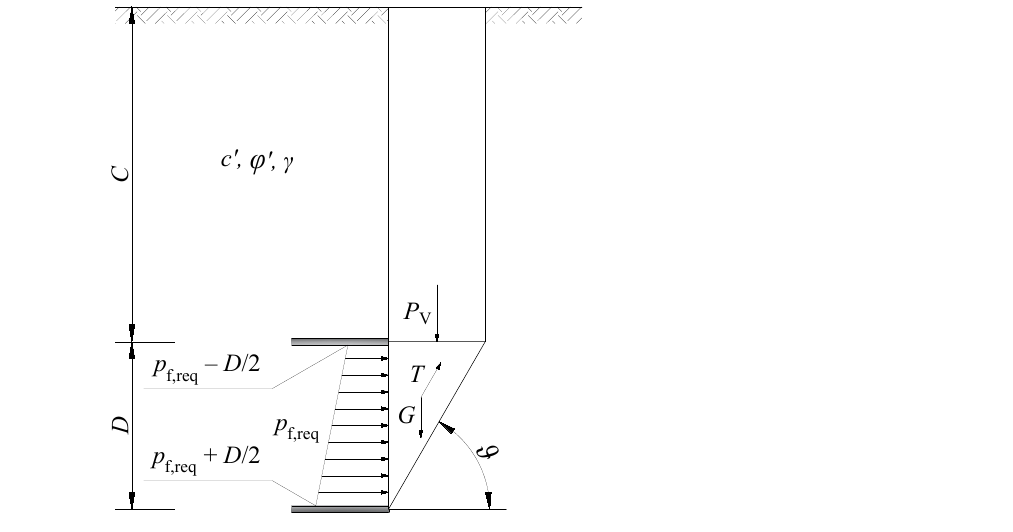
Figure 2. Tunnel face failure mechanism and forces acting on the sliding wedge according to